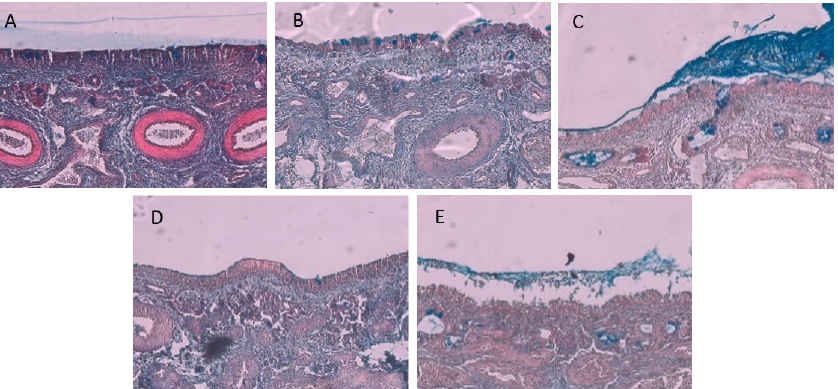
Figure 6. Micrographs of the respiratory sheep nasal epithelial tissue: ( A ) the intact control, ( B ) after exposure to insulin control group, ( C ) after exposure to microparticles consisting of Eudragit ® L100 and A. vera polysaccharides prepared by the emulsion-solvent evaporation, ( D ) after exposure to microparticles consisting of A. vera polysaccharide prepared by the emulsion-solvent evaporation, and ( E ) after exposure to microparticles consisting of A. vera polysaccharide prepared by ionic gelation.